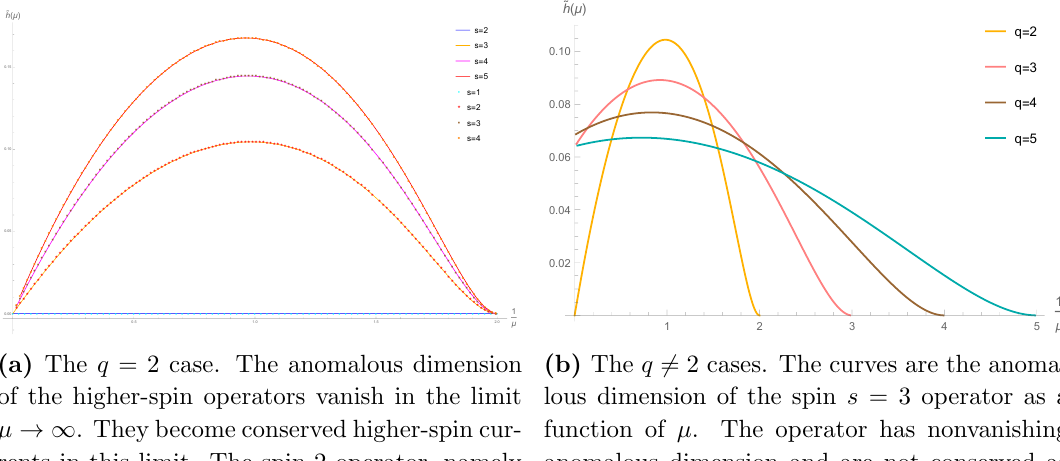
(a) The q = 2 case. The anomalous dimension of the higher-spin operators vanish in the limit (cid:22) ! 1 . They become conserved higher-spin cur- rents in this limit. The spin-2 operator, namely the stress-energy tensor, is always conserved for the whole range of (cid:22) where our SYK solution is reliable. Figure 9. The anomalous dimension of the almost holomorphic higher-spin operators as a function of 1 for the entire range of (cid:22) . (cid:22)